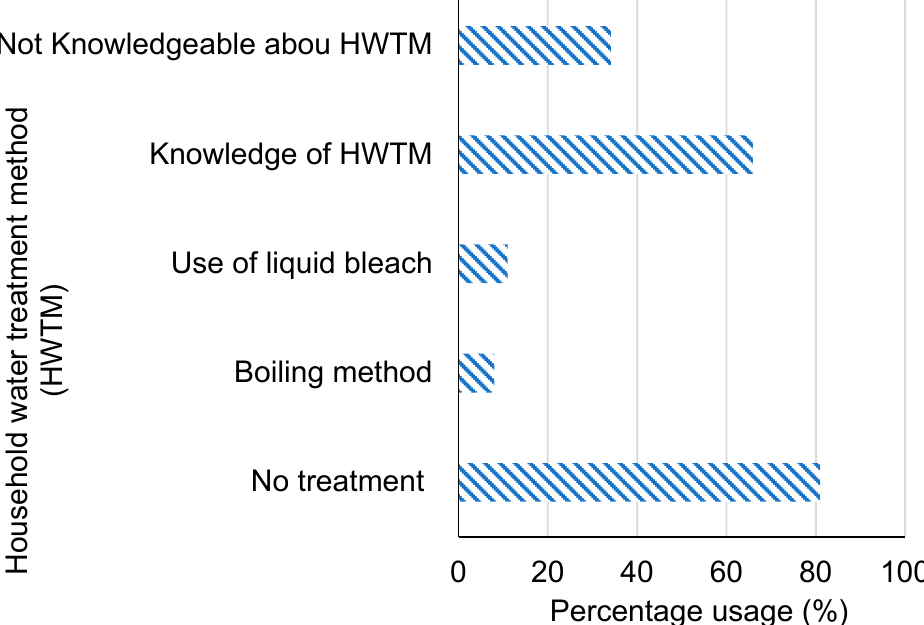
Figure 4. Water treatment methods practised in the households of Makwane Village during the study period. Table 3. Relationship between the knowledge of practised household water treatment methods and selected demographic profiles in Makwane Village prior to the implementation of